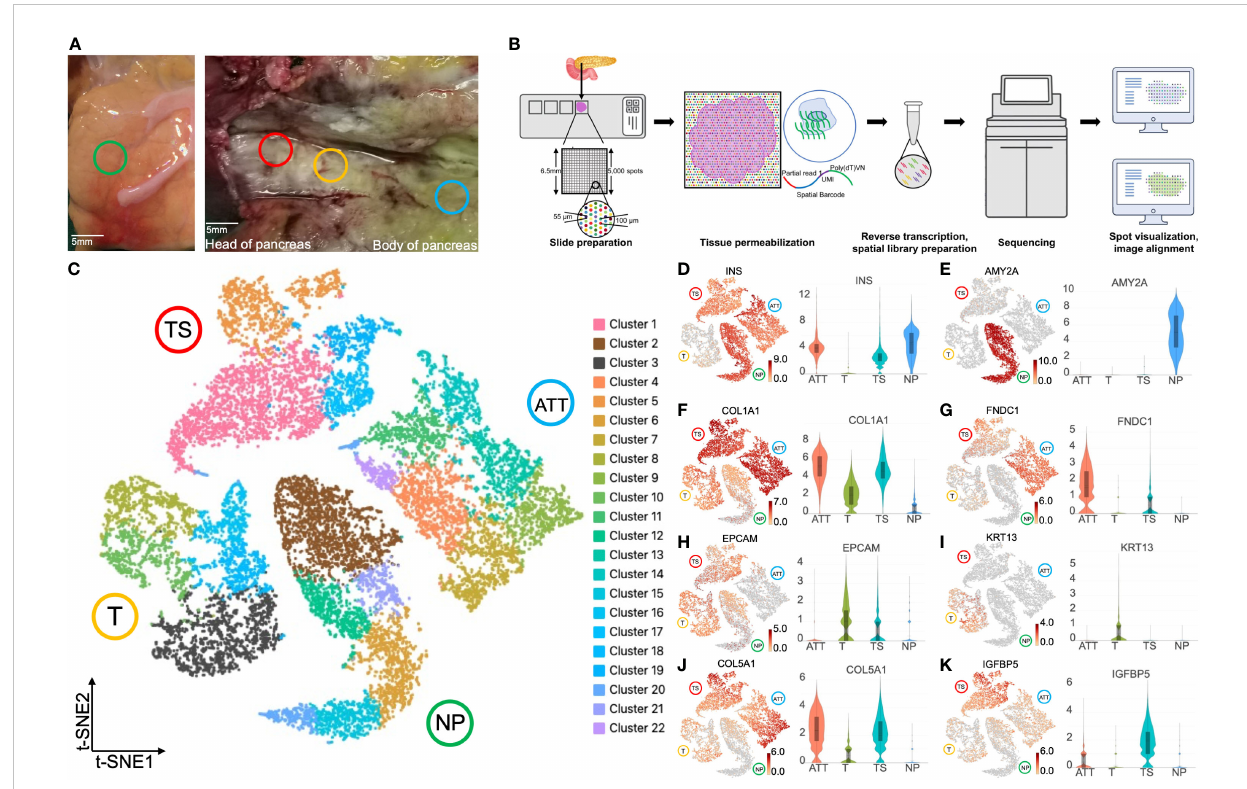
FIGURE 1 Spatial transcriptomics clustering and marker genes of four pancreatic tissues at different locations. (A) Normal pancreas tissue (NP, green circle) and pancreatic ductal adenocarcinoma tissues, including tumor (T, yellow circle), tumor stroma (TS, red circle), and adjacent tumor tissue (ATT, blue circle), were selected to perform spatial transcriptomics. (B) The experimental fl ow chart of this study. (C) t-SNE plot of 18,075 spots from the four pancreatic tissues showing 22 clusters in different colors. Cluster 3 (black spots) overexpressed KRT13 and was identi fi ed as malignant cells. Cluster 2 (brown spots) highly expressed AMY2A and EPCAM, and was determined to be healthy pancreatic ductal cells. Gene expression intensity distribution plots and violin plots of INS (D) , AMY2A (E) , COL1A1 (F) , FNDC1 (G) , EPCAM (H) , KRT13 (I) , COL5A1 (J) , and IGFBP5 (K) . The bar plots and the vertical coordinate of the violin plots indicates the log 2 FC of the gene expression value of each cluster versus the average gene